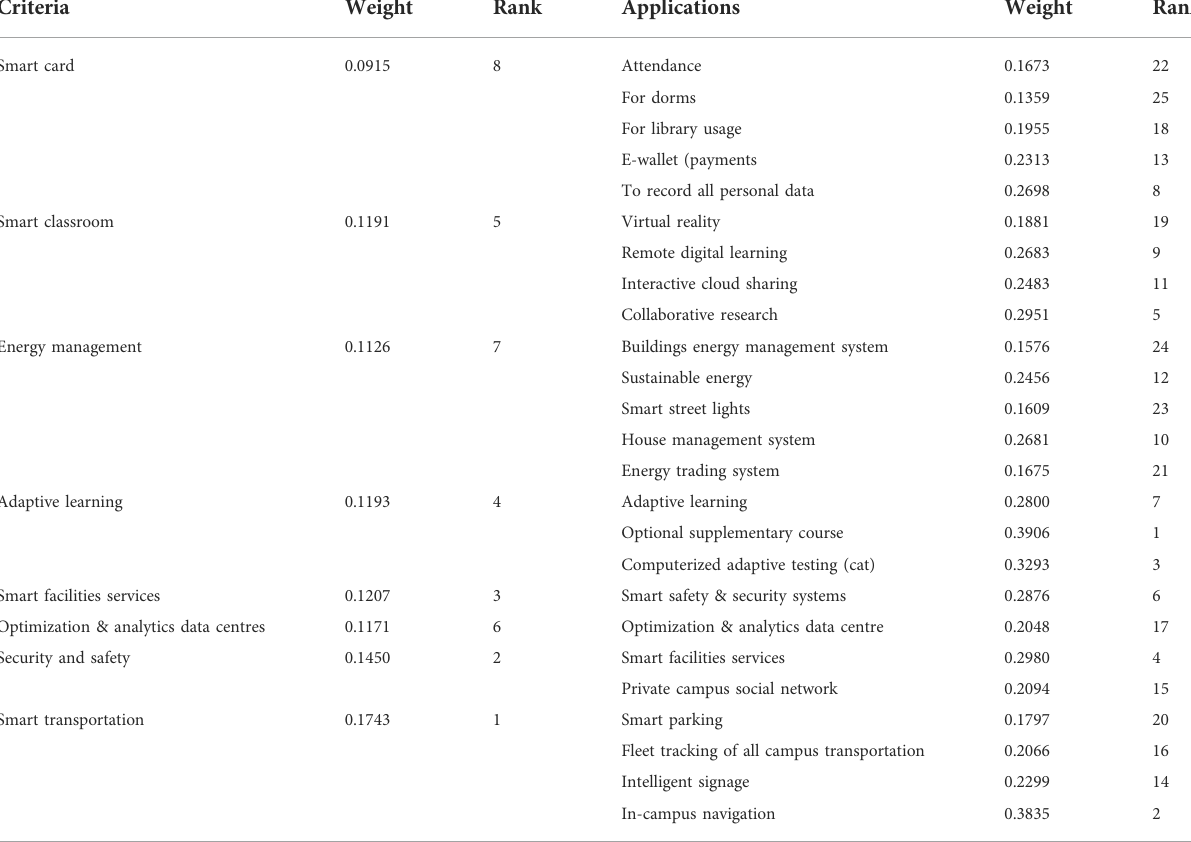
TABLE 5 Academic faculty perception regarding signi fi cant smart campus